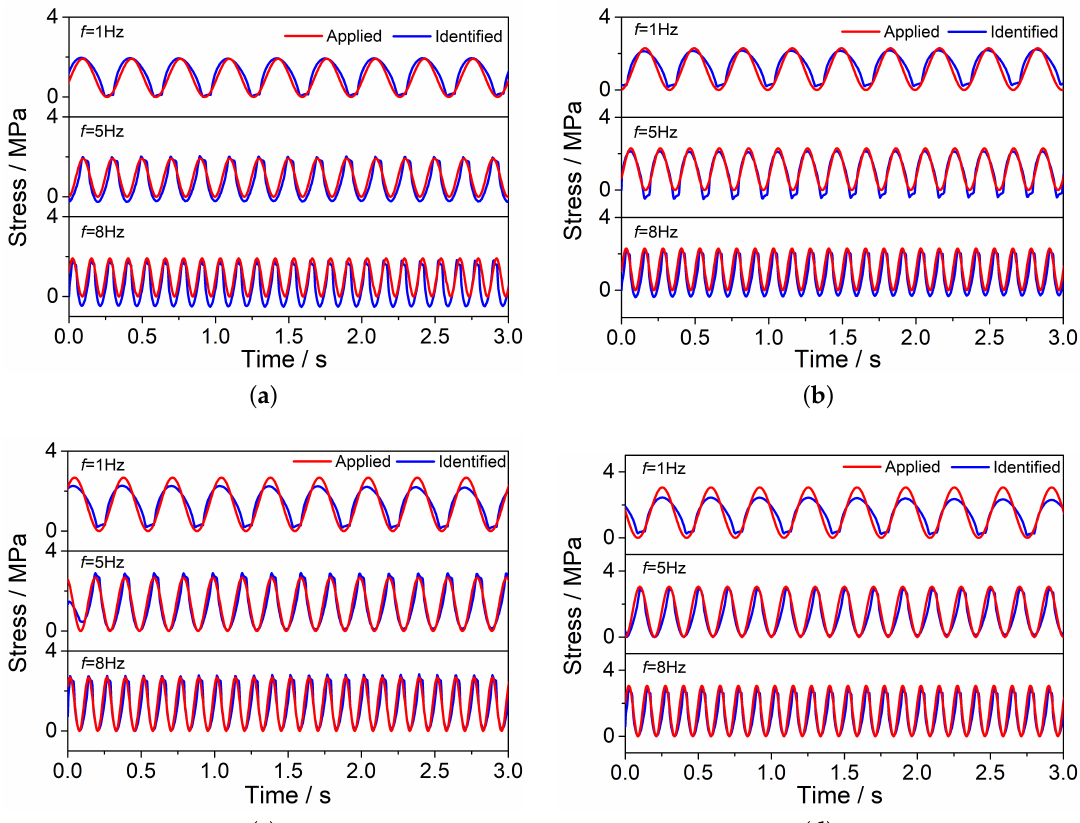
Figure 5. The Voltage signals and identified results of the MTS test. ( a ) Identified results of No .1 PZT chip with three different loading frequencies under 45 kN load; ( b ) Identified results of No .1 PZT chip with three different loading frequencies under 54 kN load; ( c ) Identified results of No .1 PZT chip with three different loading frequencies under 63 kN load; ( d ) Identified results of No .1 PZT chip with three different loading frequencies under 72 kN load.